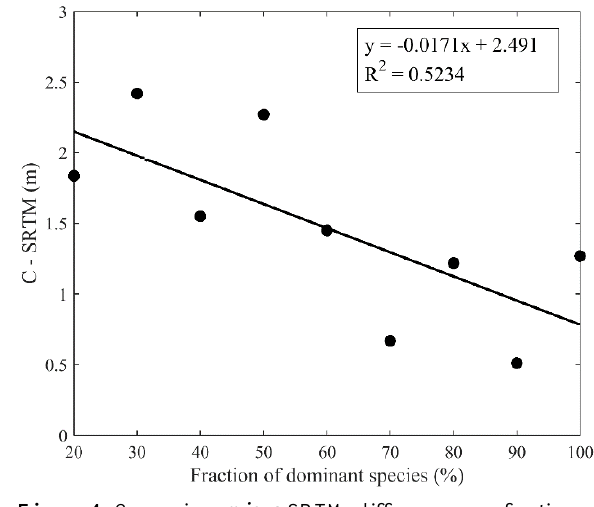
Figure 4 . Copernicus minus SRTM difference vs a fraction of dominant species (Spruce). A linear trend line is also shown.